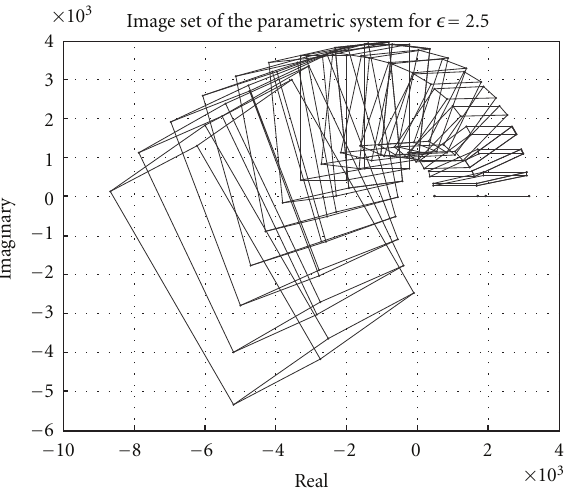
Figure 4: Kharitonov’s templates with ε 1 = 2 . 5.